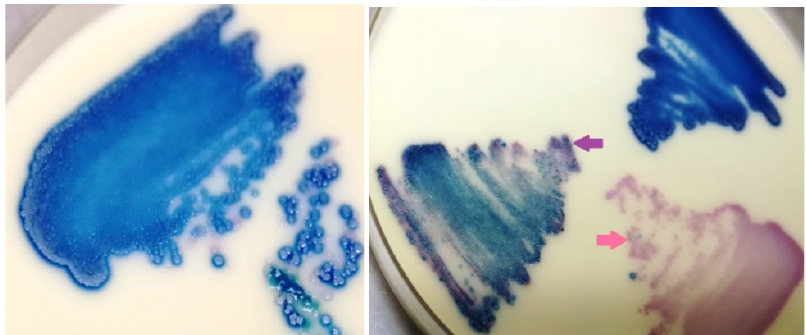
Figure 1. (Left) Streptococcus agalactiae (blue colonies) on StrepBSelect Agar (Right) Enterococcus spp . (purple arrow) and Lactobacillus (pink arrow) growing on StrepBSelect Agar